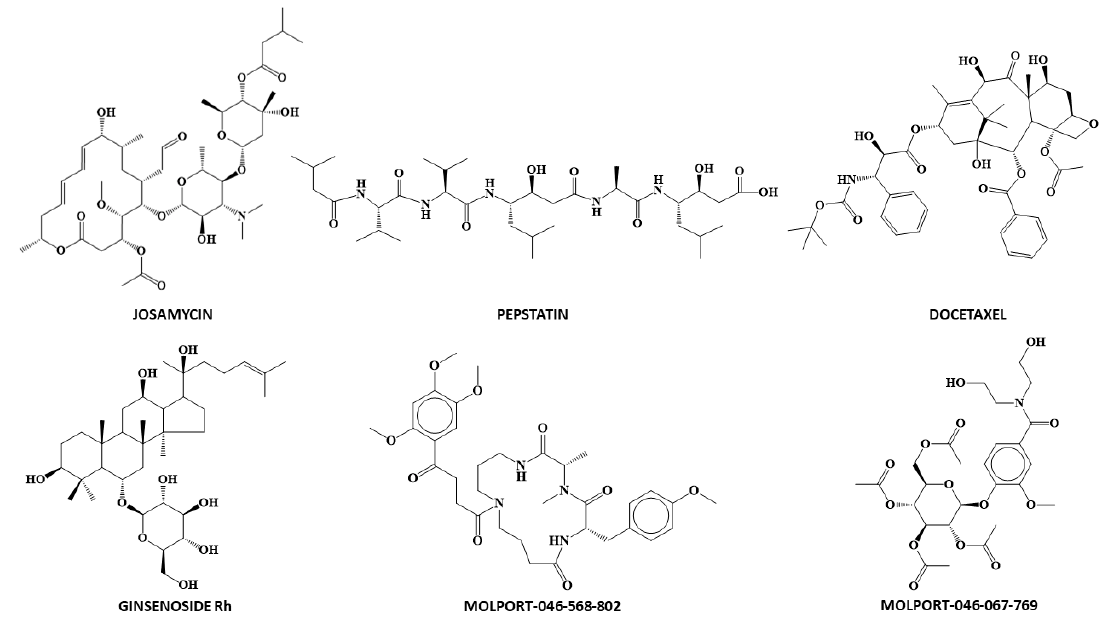
Figure 7. Chemical structure of the molecules (n = 6) selected during virtual screening.